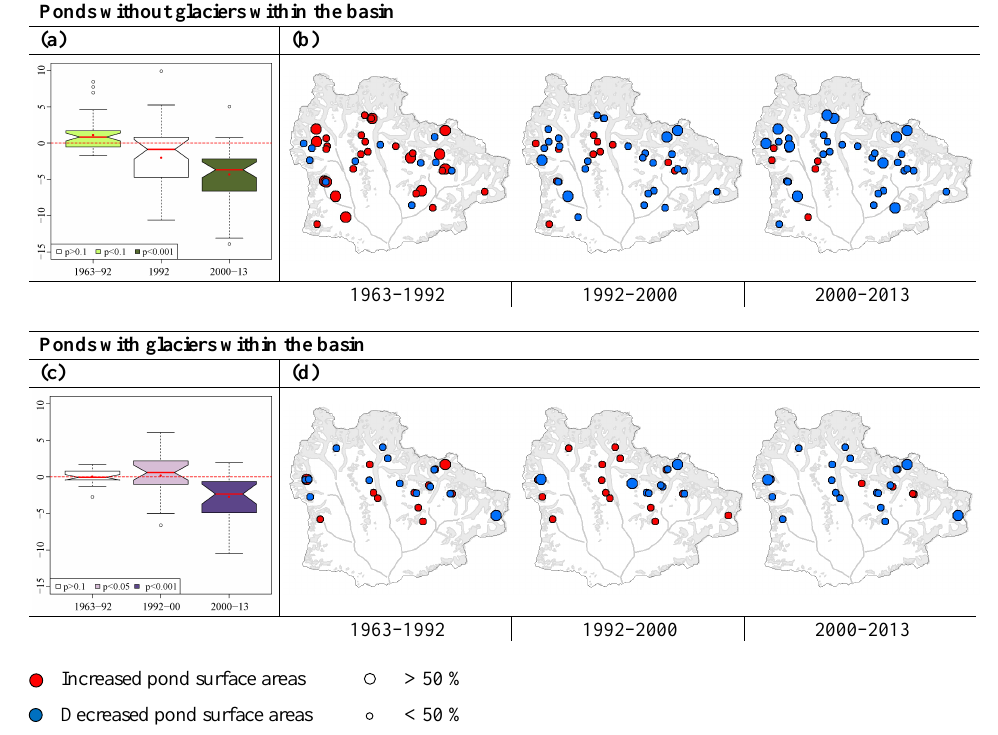
Figure 8. Changes in pond surface area in the Mt Everest region. The left box plots represent the annual rates of change of ponds in the analysed periods: (a) ponds without glaciers within the basin, (c) ponds with glaciers within the basin. The red points in the box plots indicate the mean, whereas the red lines indicate the median. Data are expressed in %yr − 1 . On the right side, the maps (b, d) visualize the variations that occurred in the pond population during the same three periods considered in the relevant box plots on the left. Reference data are reported in Table 3. All percentages refer to the initial year of the analysis (1963).